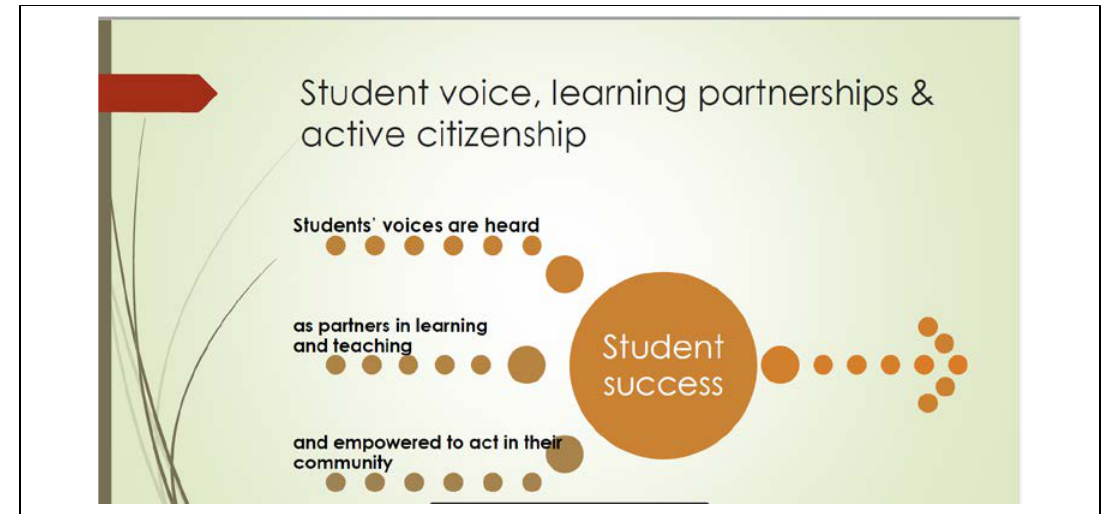
Figure 3: Student voice, learning partnerships & active